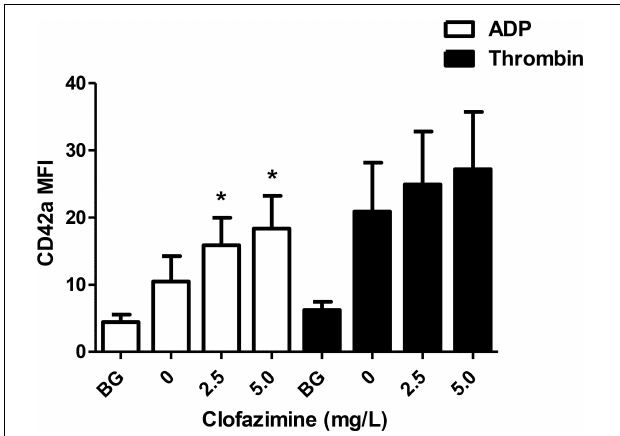
FIGURE 2 | Effects of clofazimine at concentrations of 2.5 and 5 mg/L on the formation of neutrophil:platelet heterotypic aggregates following activation of buffy coat cell suspensions with ADP (100 µ M; data from seven experiments using cells from seven different donors) or thrombin (0.31 NIH units/mL; data from 10 different experiments using cells from eight different donors). Results are expressed as the mean fluorescence intensity (MFI) of CD42a-PE emitted by CD16 + /CD45 + neutrophils. ∗ P < 0.05 for comparison of clofazimine-treated ADP- or thrombin-activated systems with the corresponding clofazimine-free control